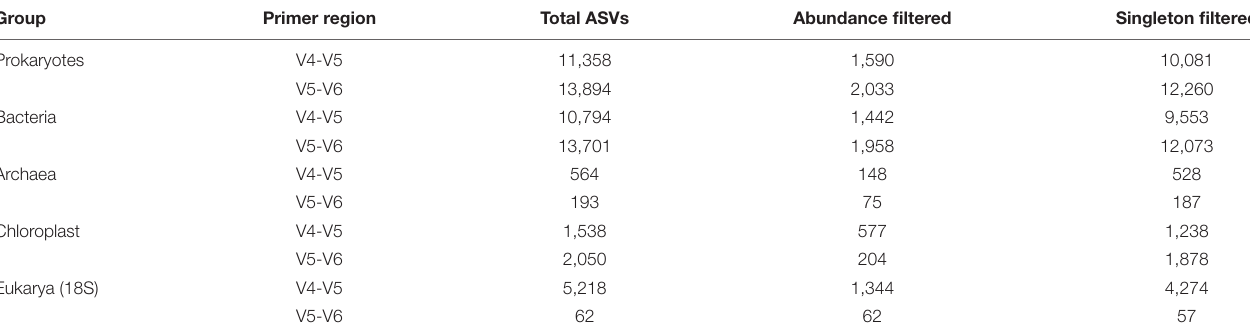
FIGURE 1 | Cruise of Polarstern ANT 28-5: Stations and hydrography along the transect. (A) Location of the 26 stations, assignment to Longhurstian provinces (FKLD: Southwest Atlantic Shelves, SATL: South Atlantic Gyre, WTRA: Western Tropical Atlantic, NATR: North Atlantic Gyre, NAST: North Atlantic Subtropical, NADR: North Atlantic Drift), overlayed by annual sea surface temperature (SST) (B–D) contour plots of temperature, salinity, and chlorophyll fluorescence of the upper 300 m (0–300 m) based on continuous measurements at each station with temperature, salinity, and fluorescence probes. Sample locations are indicated with black dots. TABLE 1 | ASVs analyzed in this